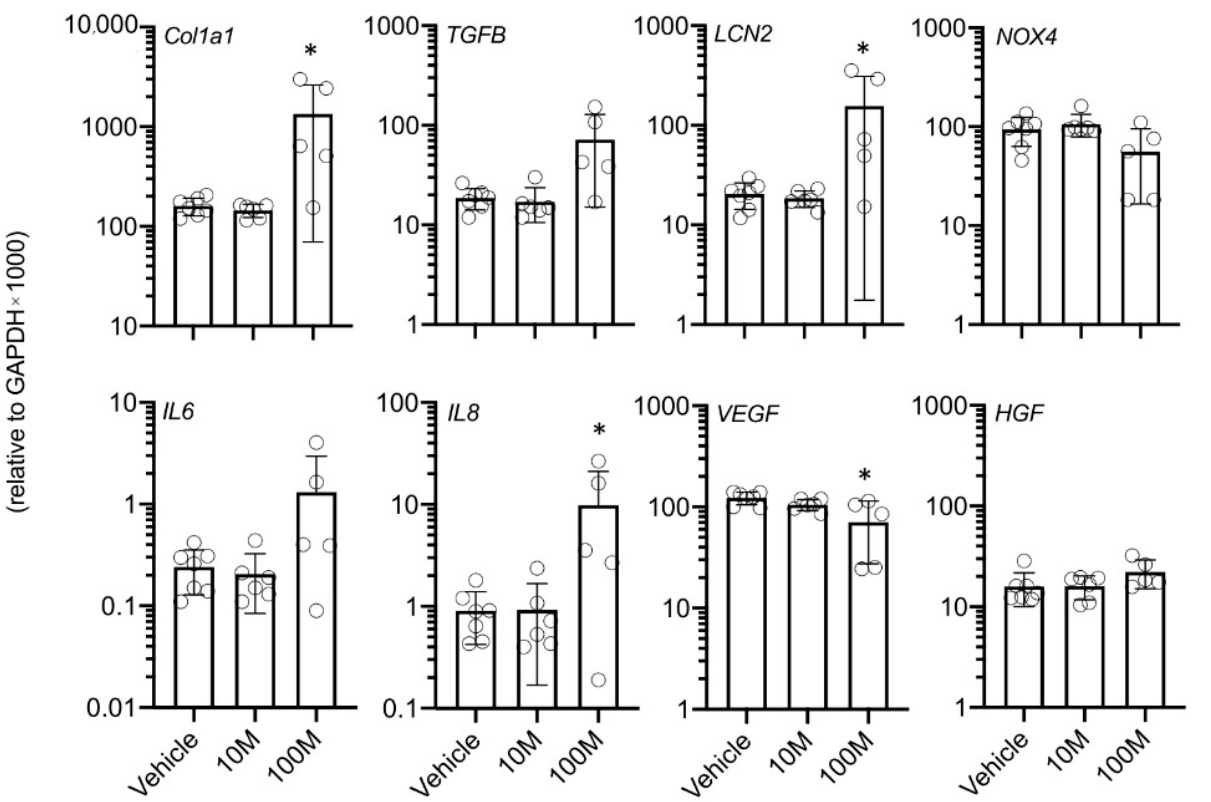
Figure 4. mRNA expression analysis of the treated kidney (cortical tissue) two weeks after intra- renal arterial MSC administration (right kidney). The animals were treated with vehicle (PBS; n = 7), ten million MSCs (10M; n = 6), and one hundred million MSCs (100M; n = 5). Collagen, Type I, alpha 1 chain (Col1a1). Transforming growth factor beta (TGFB). Lipocalin 2/Neutrophil gelatinase-associated lipocalin (LCN2). NADPH oxidase 4 (NOX4). Interleukin 6 (IL6). Interleukin 8 (IL8). Vascular endothelial growth factor (VEGF). Hepatocyte growth factor (HGF). * p < 0.05 vs. vehicle group. Graphs present the individual values, the mean, and standard deviation.